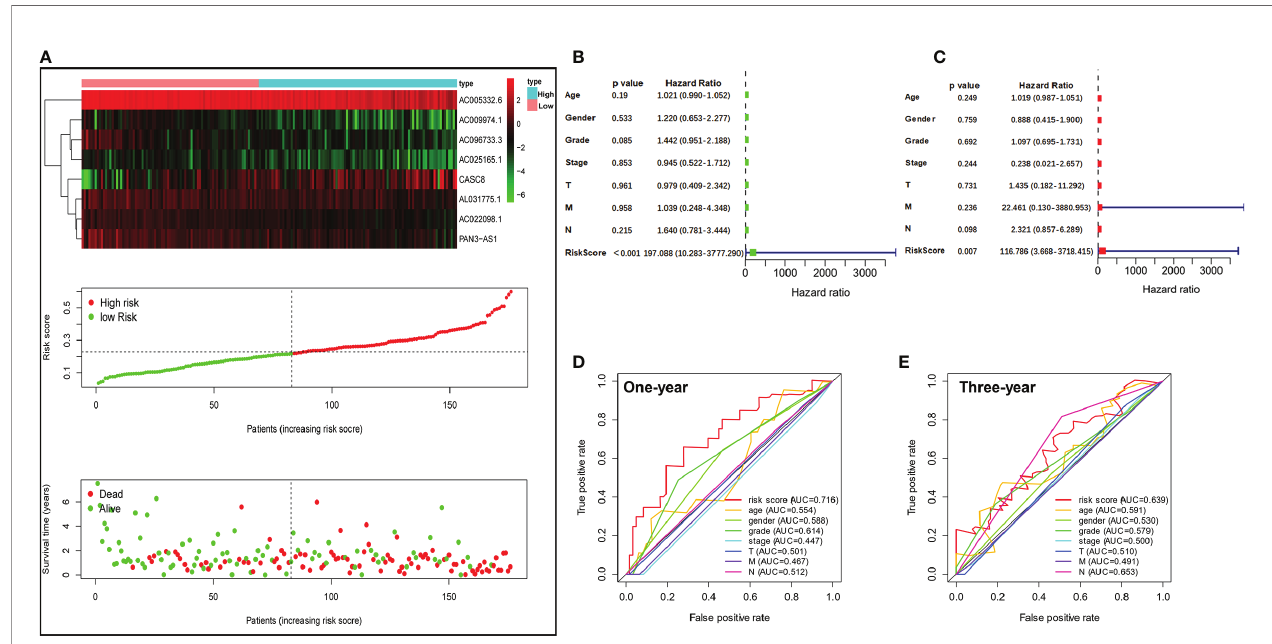
FIGURE 4 | Valuation of the m5C-related lncRNA risk model as an independent prognostic factor for PDAC. (A) Heatmap showed the differential expression of the 8 m5C-related lncRNAs in the high- or low-risk group. Scatter plot displayed risk score distribution of high-risk and low-risk PDAC patients based on the m5C- related lncRNA risk model and the relationship between survival time and PDAC patients risk score. (B) Univariate Cox regression analysis revealed the association between patients ’ survival and clinicopathological parameters along with m5C-related lncRNA risk score. (C) Multivariate Cox regression analysis uncovered that only the risk score ( p = 0.009) was an independent prognostic factor for PDAC patients. (D, E) The 1-year (D) and 3-year (E) ROC analysis revealed the AUCs of m5C- related lncRNA risk score and other clinical